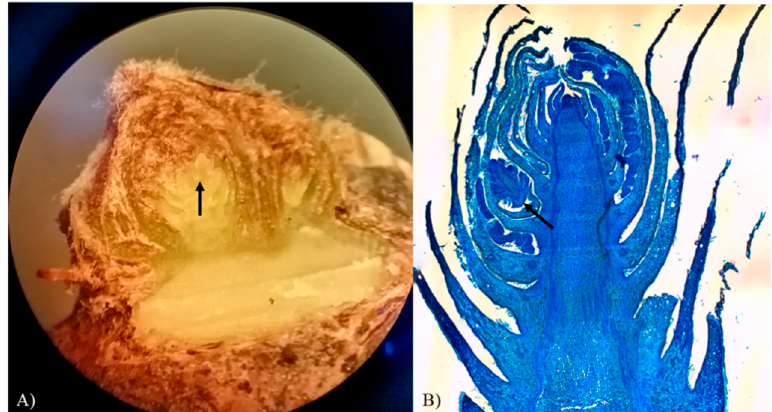
Figure 3. ( A ) Longitudinal section of bud tissue observed under a stereomicroscope at 20× magni- fication. ( B ) Longitudinal section of a dormant bud (Fernão-Pires variety) observed under a light microscope. Black arrow, in each panel, indicates inflorescence primordia.